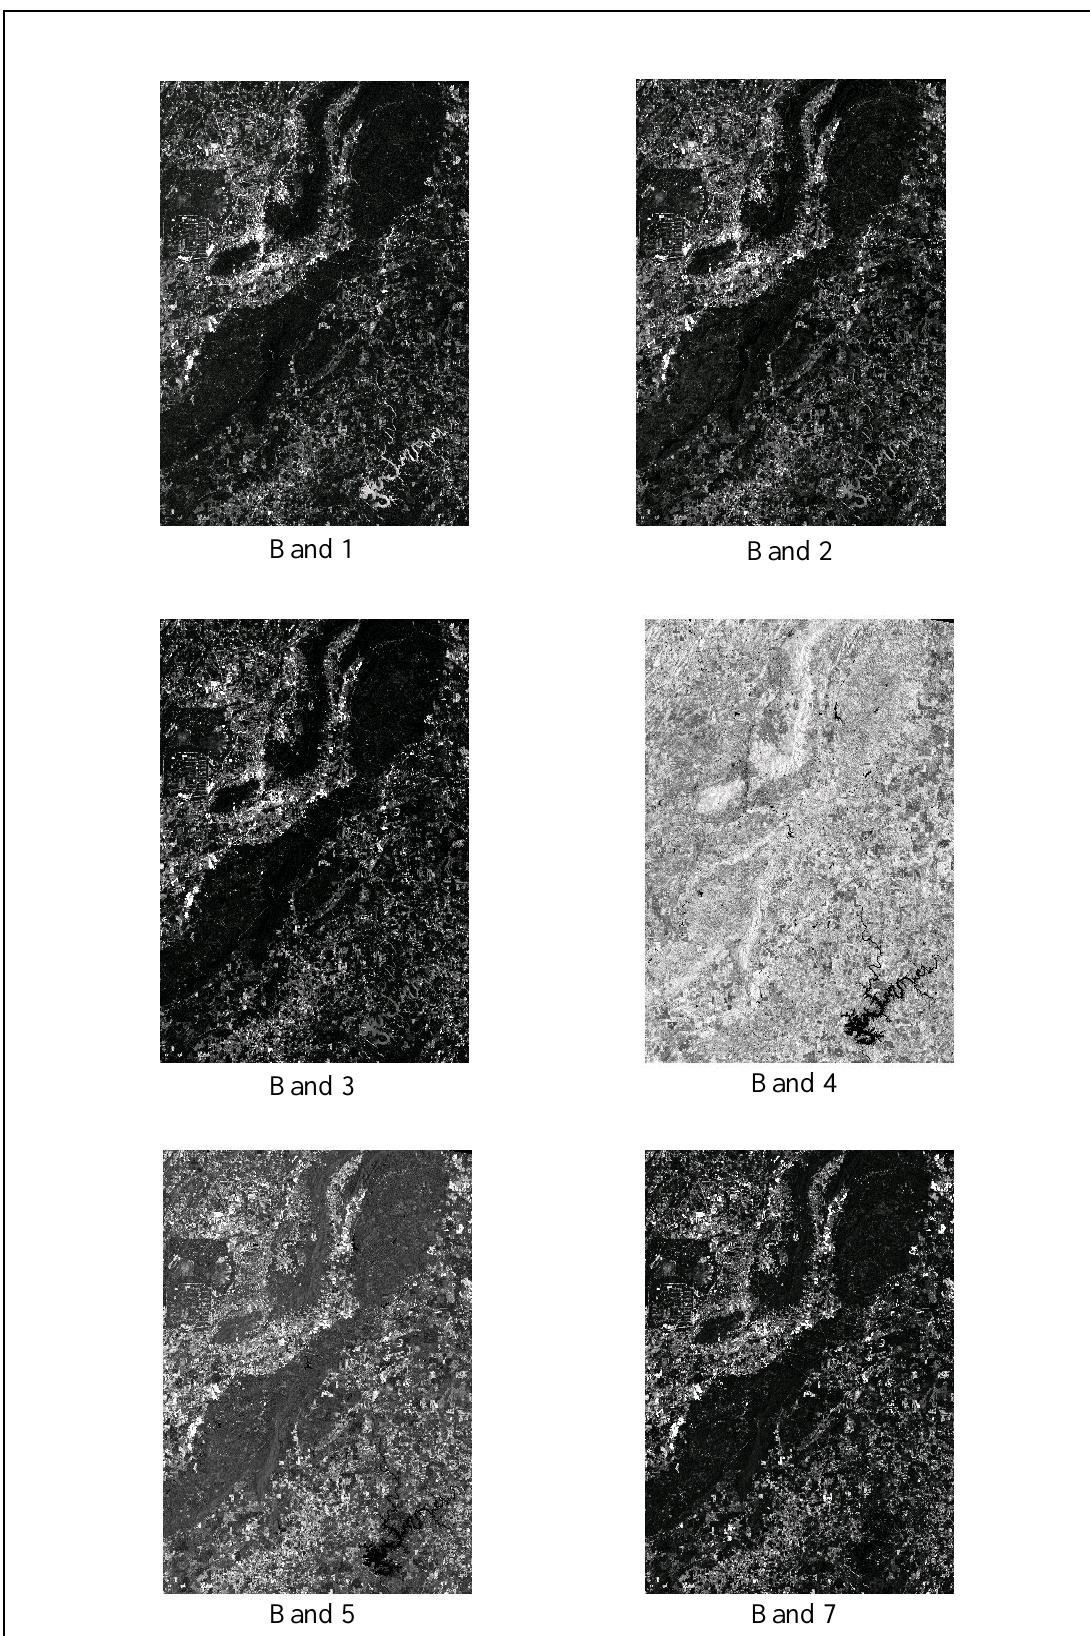
Figure 8. Multiple spectral images of Talladega National Forest, AL,